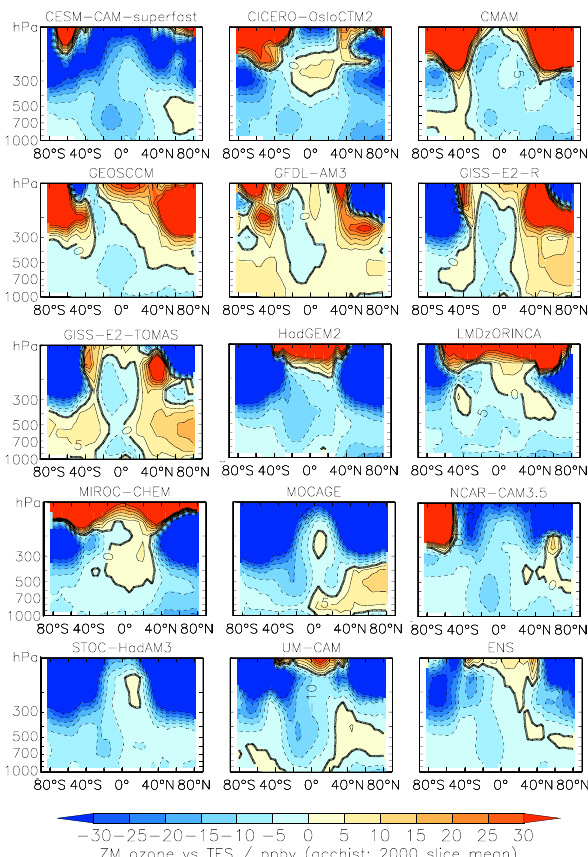
Fig. 2. Zonal bias between ACCMIP models and TES ozone aver- aged over 2005–2010. Ensemble average of ACCMIP compared to Fig. 2: Zonal bias between ACCMIP models and TES ozone averaged over 2005-2010. Ensemble TES ozone is shown under ENS in the bottom average of ACCMIP compared to TES ozone is shown under ENS in the bottom right.